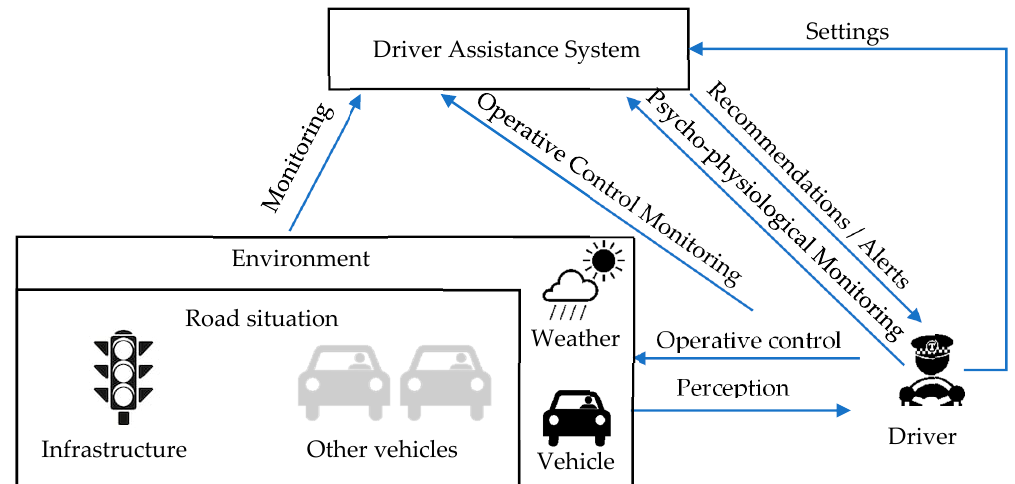
Figure 2. Influence diagram as a framework for threat analysis.